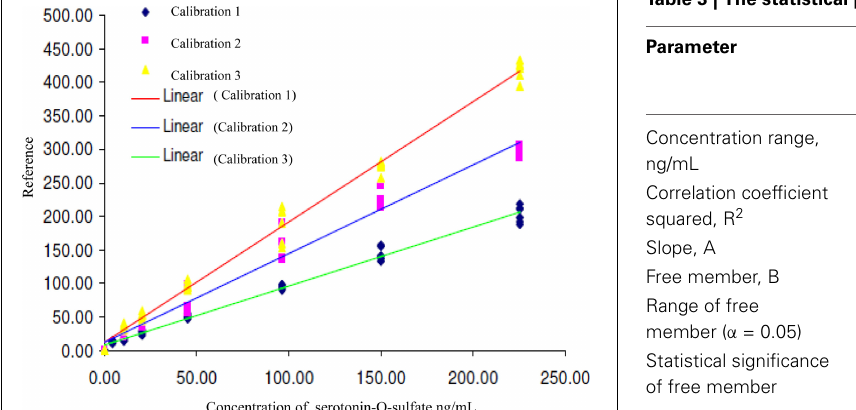
Table 3 | The statistical parameters of 5-HT-SO4 calibration